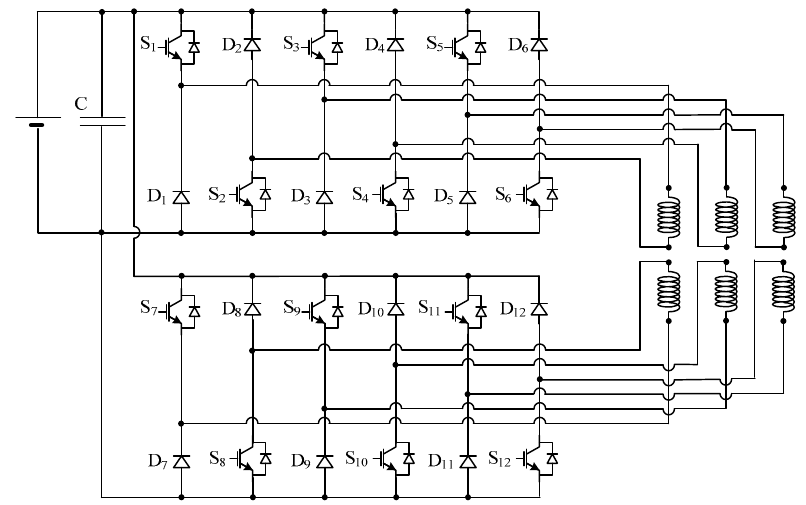
Figure 32. Fault-tolerant topology proposed by [98], based on the concept of increasing the number of inverter legs per phase. The solution uses a mutually coupled dual three-phase SRM (DTPSRM).